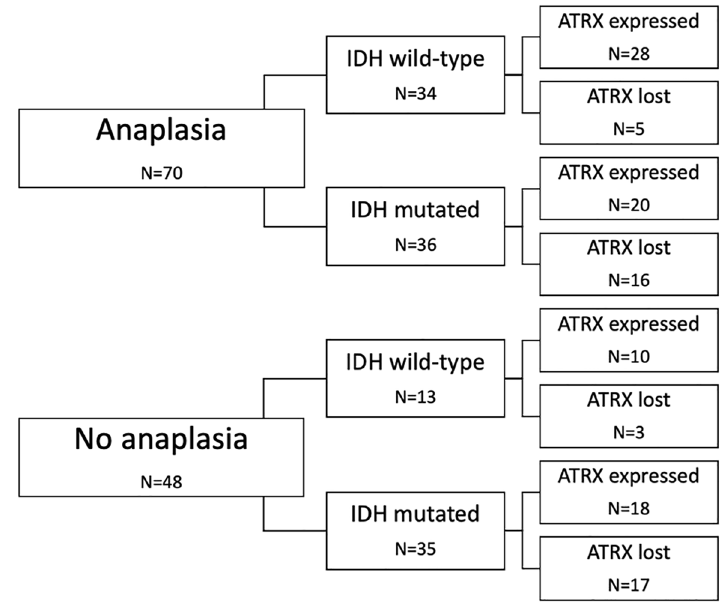
Figure 1. The stratification of anaplasia, IDH and nuclear ATRX status of our cohort.